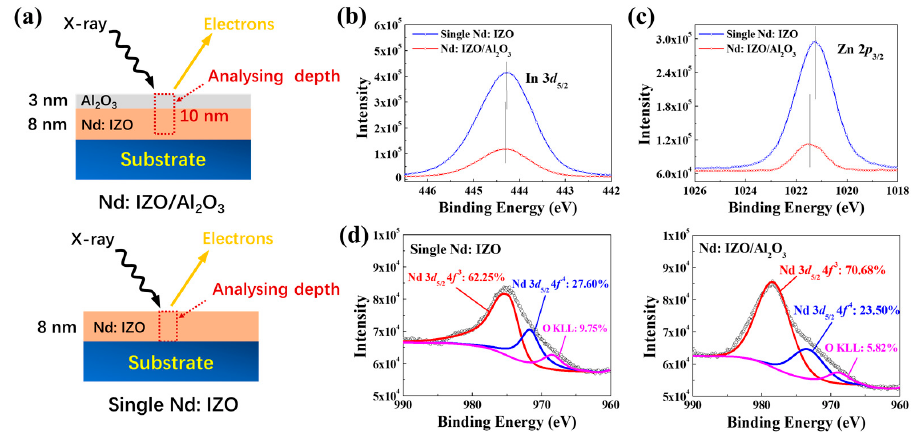
Figure 2. The ( a ) schematic illustration and ( b ) In 3 d 5/2 , ( c ) Zn 2 p 3/2 , and ( d ) Nd 3 d 5/2 core level spectra of the single Nd:IZO film and the Nd:IZO/Al 2 O 3 stacked films.